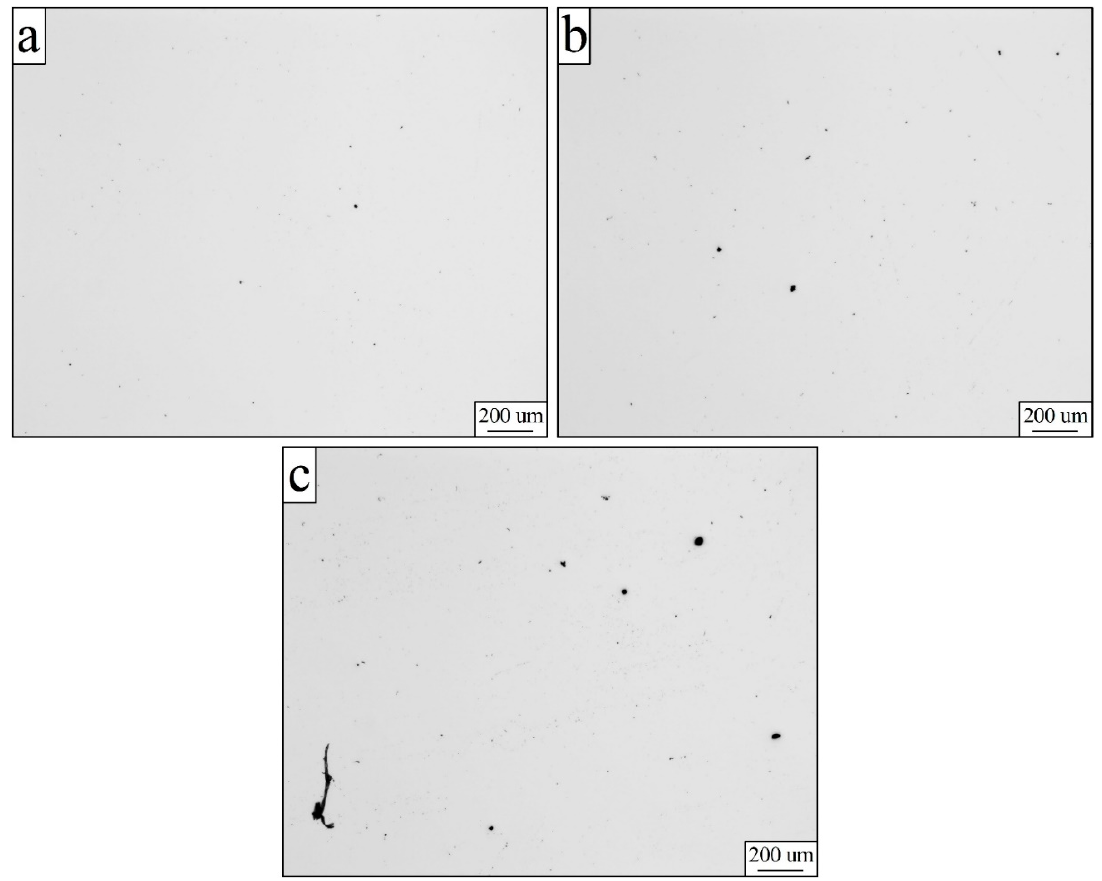
Figure 8. Results of optical microscopy of synthesized samples: ( a ) sample #10 (P = 300 W, V = 1650 mm/s); ( b ) sample #9 (P = 300 W, V = 1450 mm/s); ( c ) sample #8 (P = 300 W, V = 1250 mm/s).